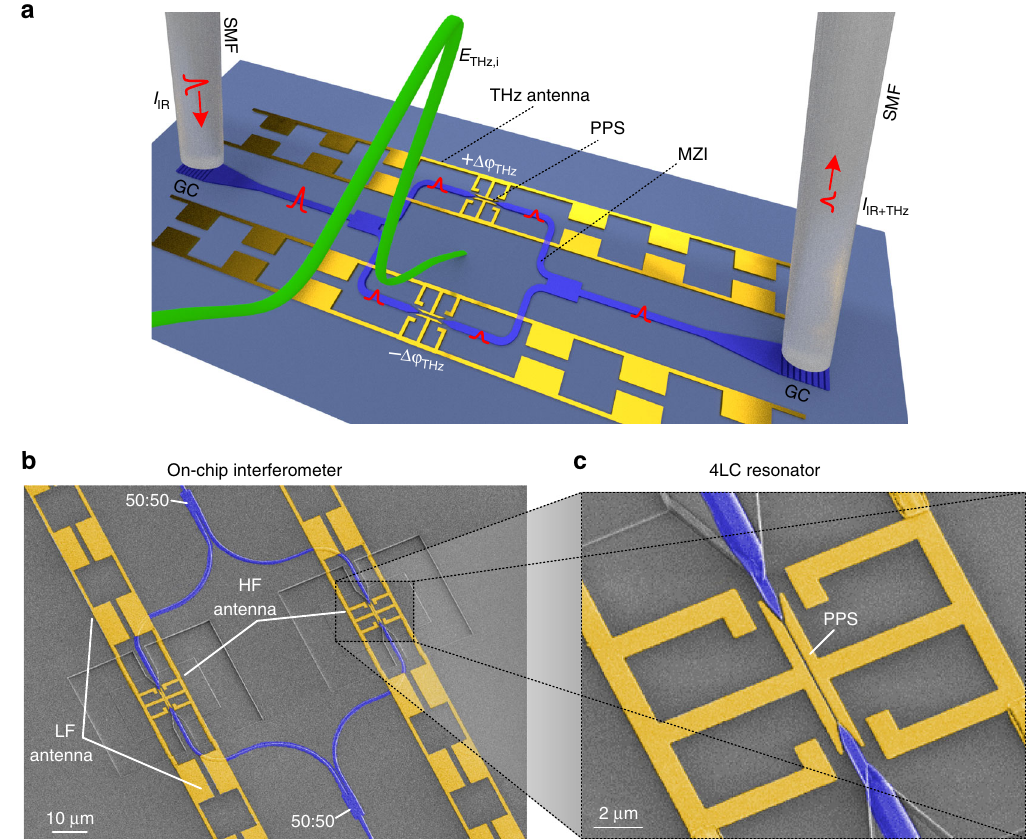
Fig. 1 On-chip terahertz detector. a The detector consists of a Mach – Zehnder interferometer (MZI) with antenna-coupled plasmonic phase shifters (PPS). An incident THz fi eld ( E THz,i ) introduces, via the linear electro-optic effect, a refractive index change in the gap of the two antenna-coupled phase shifters. This change of refractive index leads to a linear phase delay (± Δ φ THz ) of the IR probe pulses ( I IR ) traveling through the phase shifters. The phase modulation experienced by the IR probe pulses is transformed into an intensity modulation ( I IR + THz ) at the output of the interferometer. The probe pulses are coupled in and out on-chip silicon (Si) waveguides by means of grating couplers (GC). The organic electro-optic material in the two-phase shifters located in opposite arms of the MZI has opposite polarity to enable push-pull operation. Scale bar is 10 μ m. b False color scanning electron image of the fabricated multi-resonant THz detector. The antenna comprises of a high-frequency (HF) antenna and a low-frequency (LF) antenna. Each antenna is resonant within a spectral range. Combined they provide a broadband THz response. c Close-up view of the HF-THz antenna directly coupled to the PPS. Scale bar is 2 μ m. SMF single mode fi ber, 50:50: multi-mode